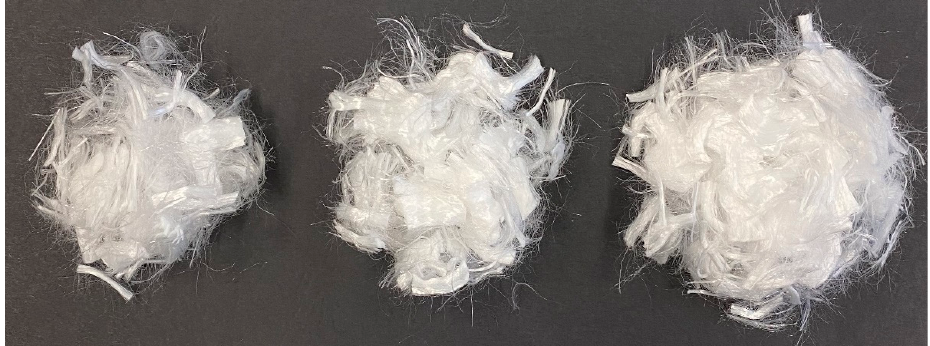
Figure 3. The 18 mm-long polypropylene fibers added at mass ratios of 0.1%, 0.2%, and 0.3% to the dry mass of the compacted soil.